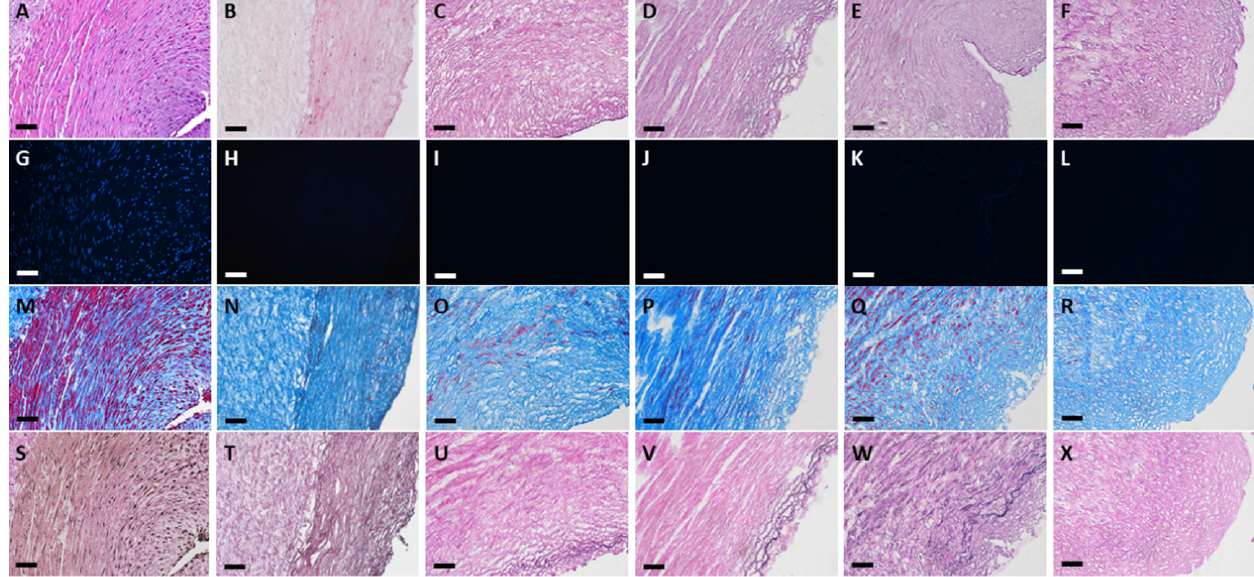
Figure 1. Histological stain of HUA, cDHUA, and sDHUA. ( A , G , M , S ) HUA; ( B , H , N , T ) cDHUA; ( C , I , O , U ) sDHUA, 204 W for 4 h; ( D , J , P , V ) sDHUA, 204 W for 8 h; ( E , K , Q , W ) sDHUA, 285 W for 2 h; ( F , L , R , X ) sDHUA, 285 W for 4 h; ( A – F ) H&E stain; ( G – L ) DAPI; ( M – R ) Masson’s trichrome stain; ( S – X ) Elastin Van Gieson’s stain; Magnification: 200 × , Scale bar = 50 µ